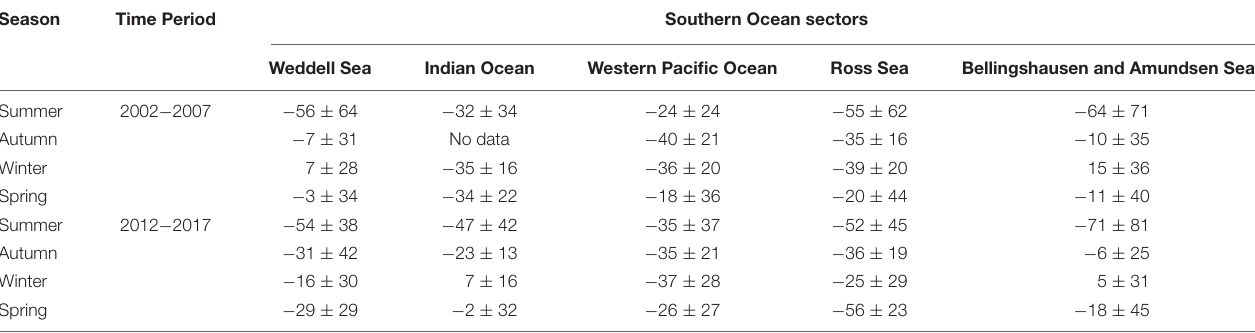
TABLE 2 | Regional average ± standard deviation of the p CO 2 difference between the surface ocean and atmosphere ( (cid:49) p CO 2 ), by season for two composited time periods: 2002 − 2007 and 2012 − 2017. Season Time